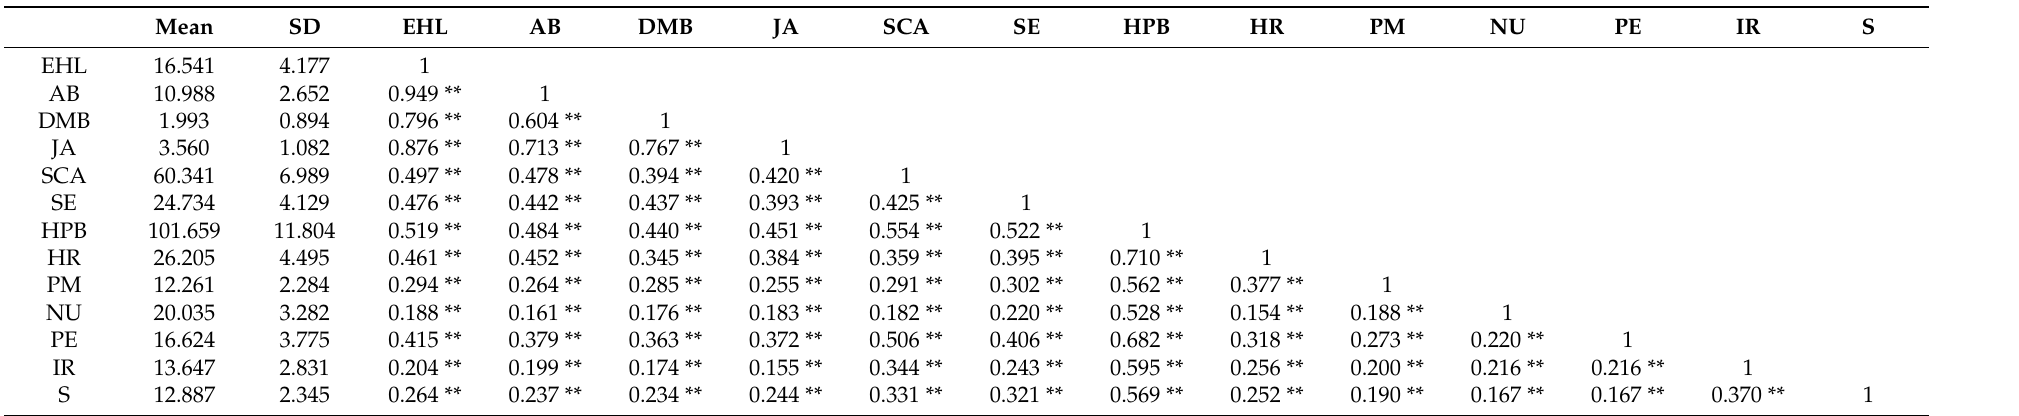
Table 2. Means, standard deviations, and correlations among